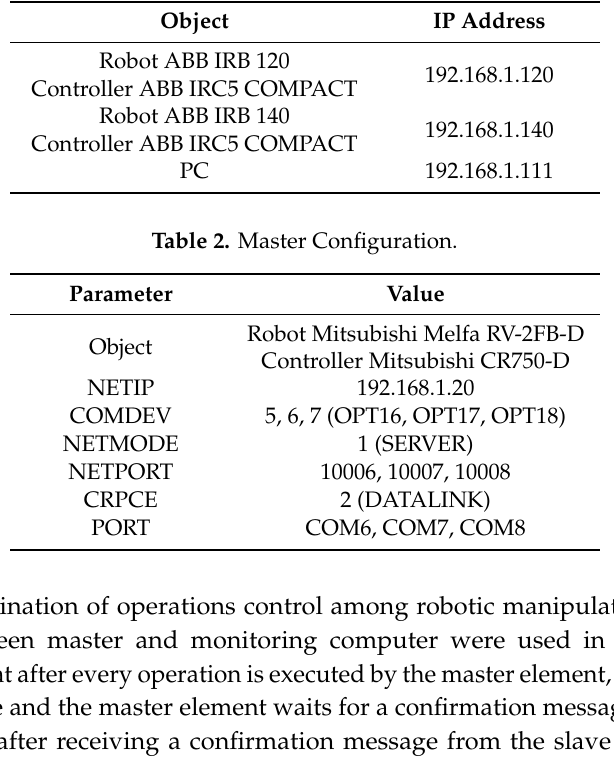
Figure 17. Desired set of operations in one production cycle.